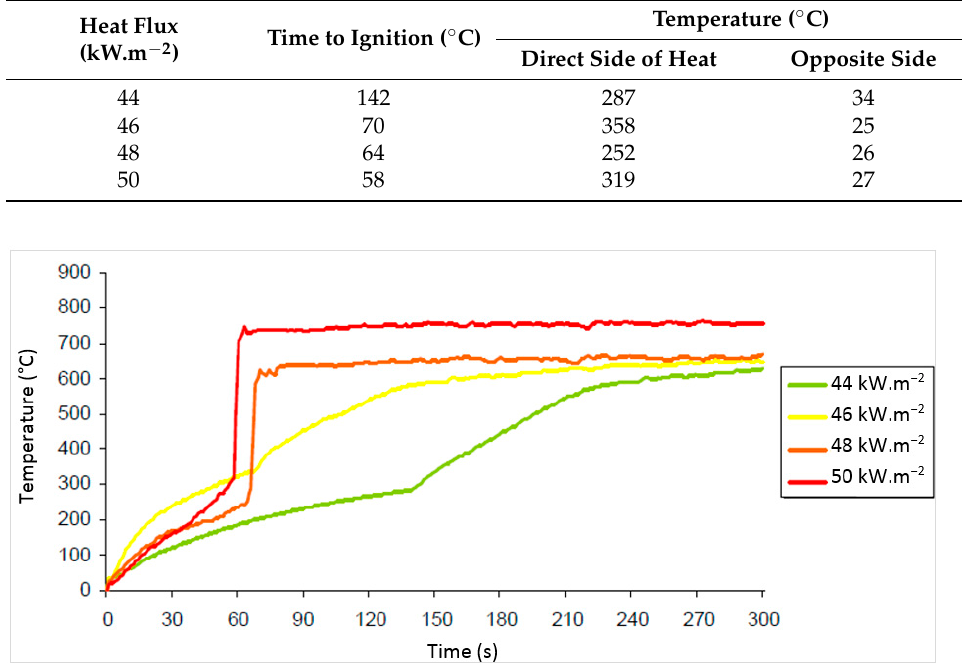
Figure 8. Temperature dependence of the upper surface of an OSB with a thickness of 15 mm on the exposure time to the cone